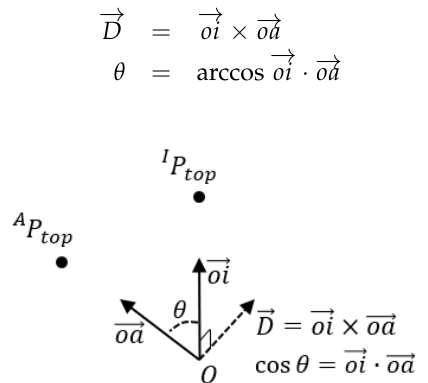
R . Because we know the position of the brush top in the I R , which transforms a point from I